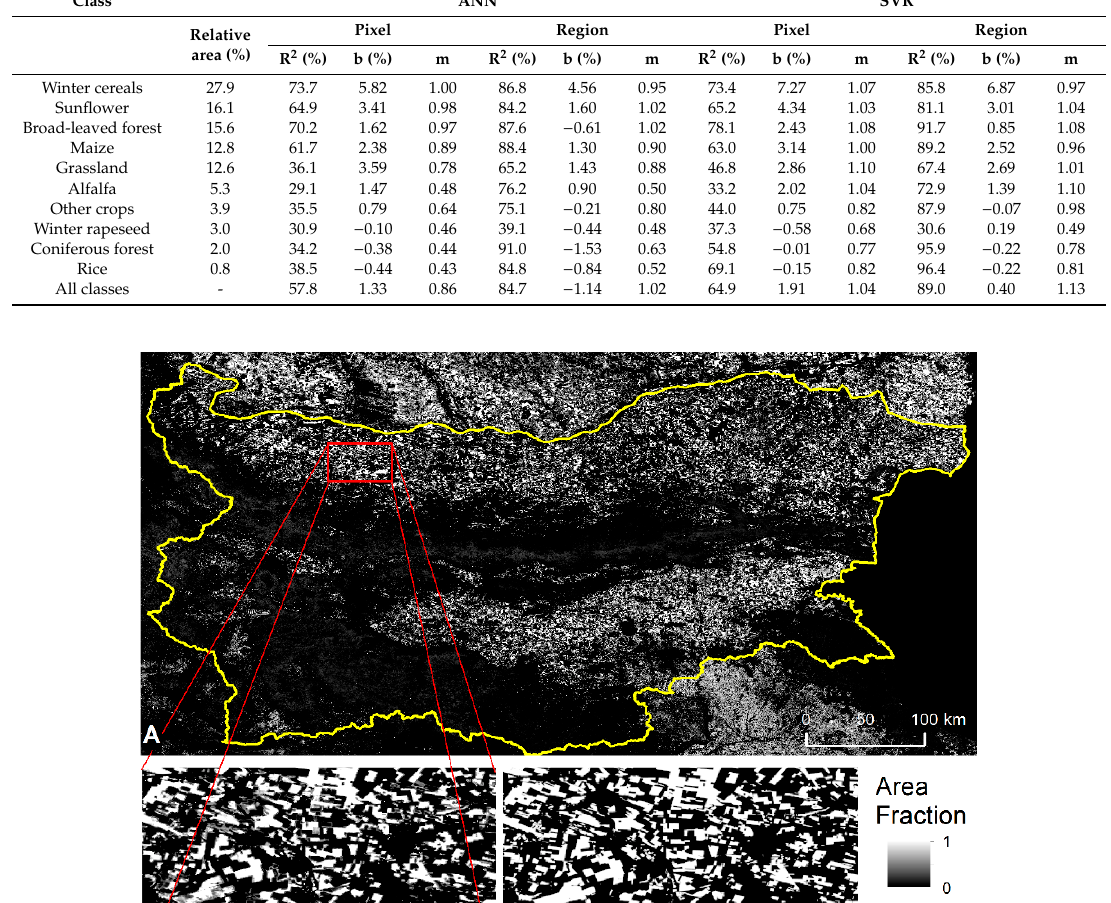
Figure 6. ( A ) Estimated area fraction image for the winter rapeseed class derived by ANN sub-pixel classification of PROBA-V 100 m NDVI time series over Bulgaria. ( B ) Excerpt from the image in (A) for part of “Knezha” test site. ( C ) True area fraction image for the same region as (B) derived from the reference Sentinel-2 classification.